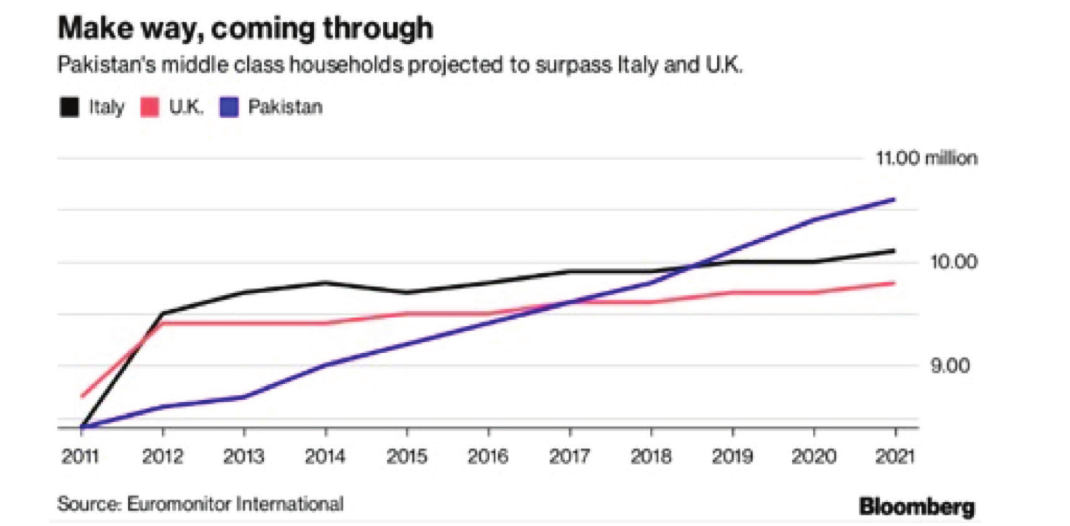
Figure 5: Projection of Pakistan’s middle